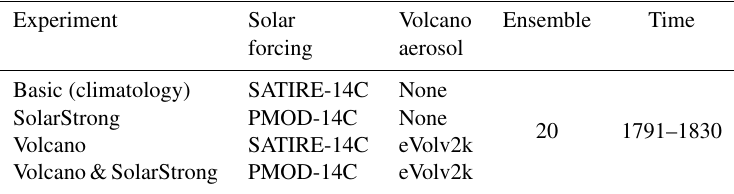
Table 1. Description of the four experiments used in this